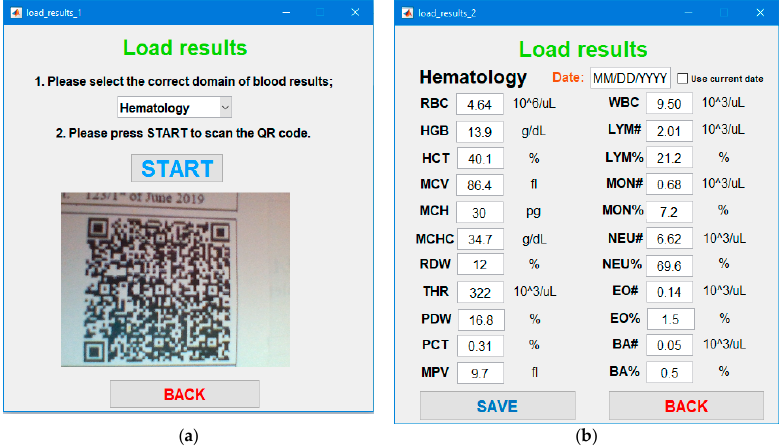
Figure 5. Loading the results via the embedded QR code from the results bulletin for hematology: ( a ) Loading the results via the embedded QR code from the results bulletin; ( b ) The recognized results from the simulated results bulletin for hematology.